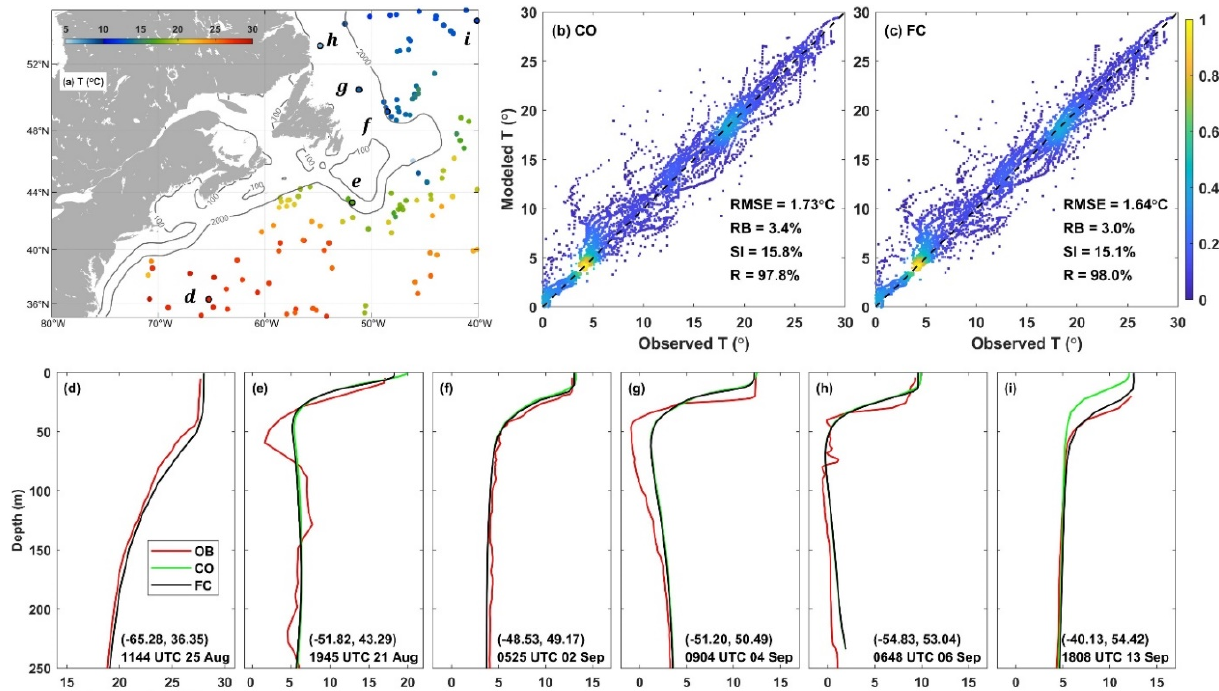
Figure 3. ( a ) Locations of Argo profiles with near-surface water temperature. Scatterplots for the water temperature between model results (( b ): run CO, ( c ): run FC) and observations from the Argo profiles during the study period (from 20 August to 20 September 2010). ( d – i ) Vertical profiles of simulated and observed water temperature at six Argo locations.